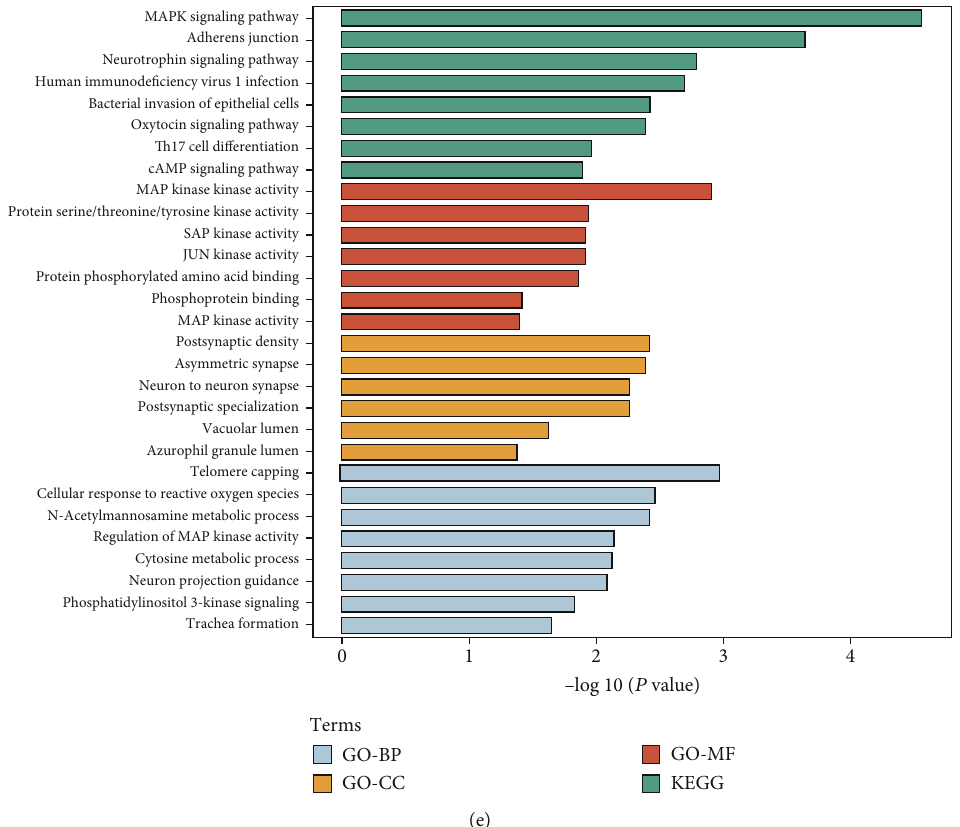
Figure 1: LncRNAs and their potential target genes in AF and SR patients. (a) Volcano plot of di ff erentially expressed lncRNAs. Red and blue dots represent the high and low di ff erential expression of lncRNAs, respectively. (b) Box plot of the LINC00636 expression in the two groups. (c) Map of binding sites between LINC00636 and miR-450a-2-3p. (d) Network map for LINC00636-related genes and miR-450a-2-3p. (e) GO and KEGG pathway enrichment